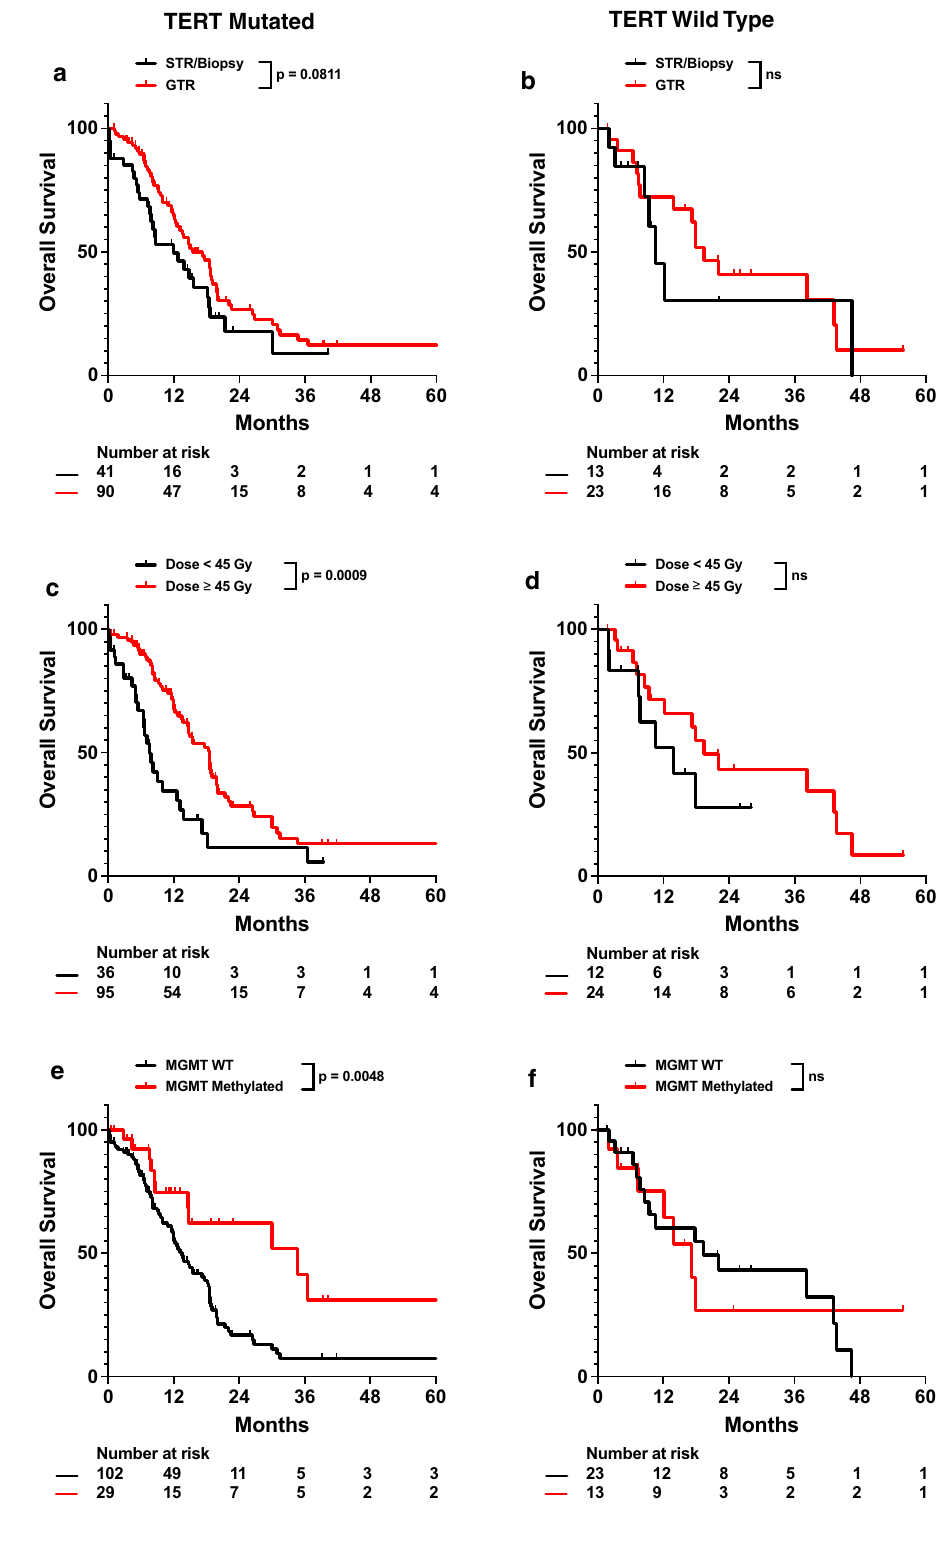
Fig. 5 Univariate impact of total resection, radiation dose, and MGMT methylation on OS in TERTmut and TERTwt cohorts Kaplan–Meyer plots of OS comparing patients with different ( a, b ) total resection status, ( c, d ) radiation dose, or ( e, f ) MGMT methylation status in TERTmut and TERTwt patients are shown. Statistical analysis was performed using Cox Proportional Hazards tests. OS, overall survival; GTR, gross total resection; STR, sub- total resection; WT, wild